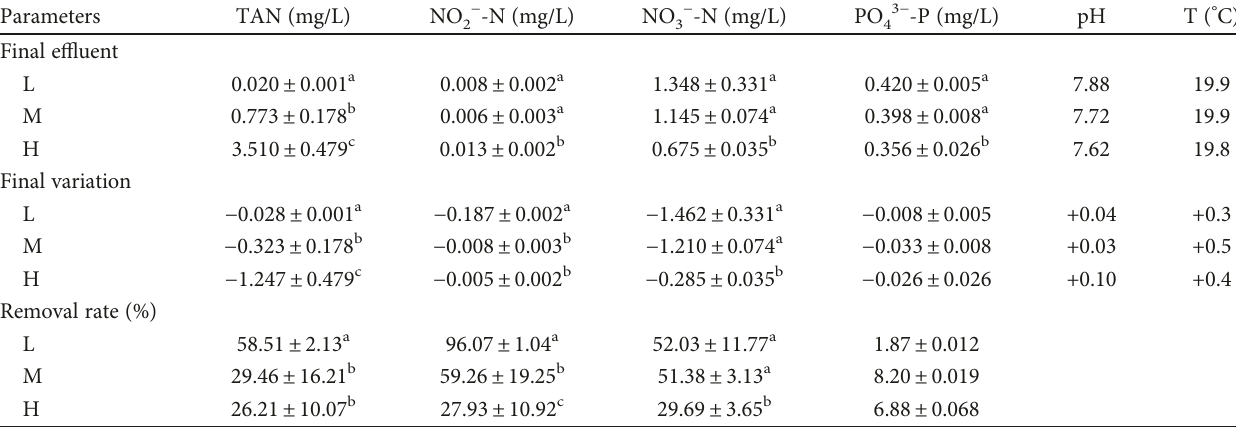
Table 1: Characteristics of the in fl uent and e ffl uent of CWs treating mariculture wastewater under di ff erent TAN concentrations.